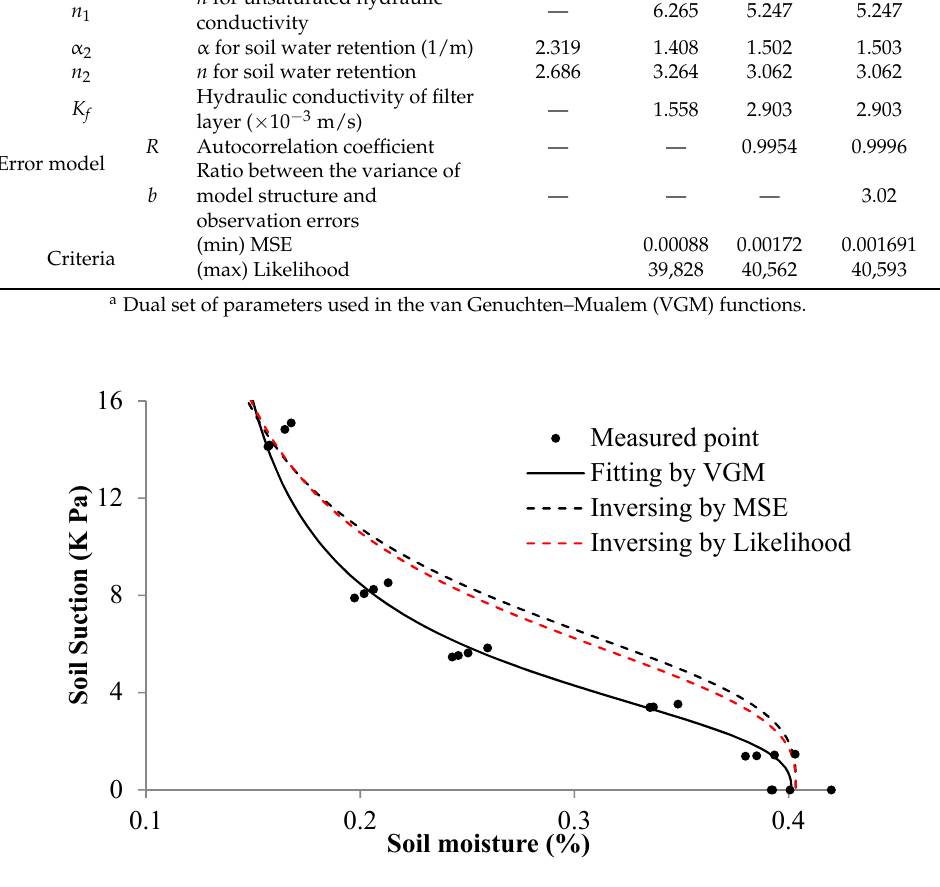
Figure 3. Comparison of the soil water retention curve measured by the refrigerated centrifuge and estimated by the inverse modeling.